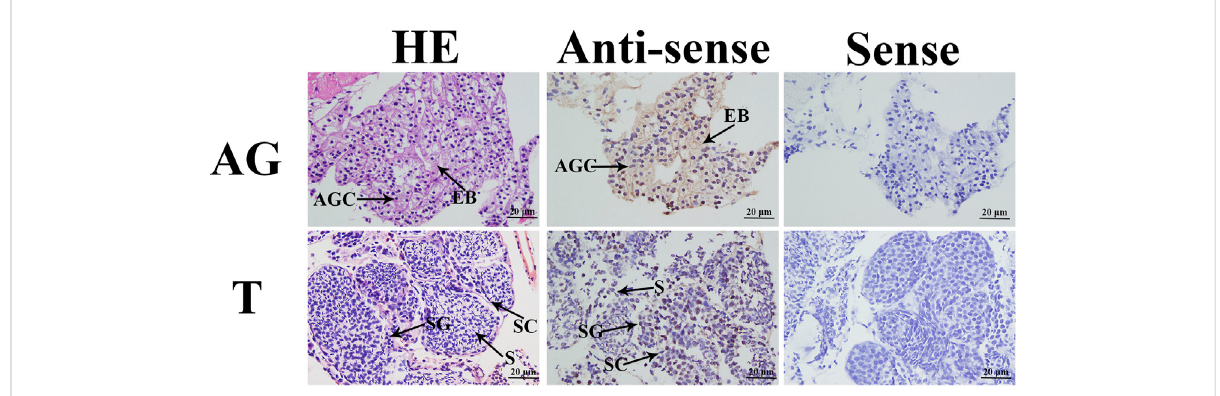
FIGURE 3 In situ hybridization analysis of Mn - CycA in the testis and androgenic gland taken from the reproductive season. SG: Spermatogonia; SC: spermatocyte; S: sperm; AGC: androgenic gland cells; EB: ejaculatory bulb. Scale bars = 20 μ m.